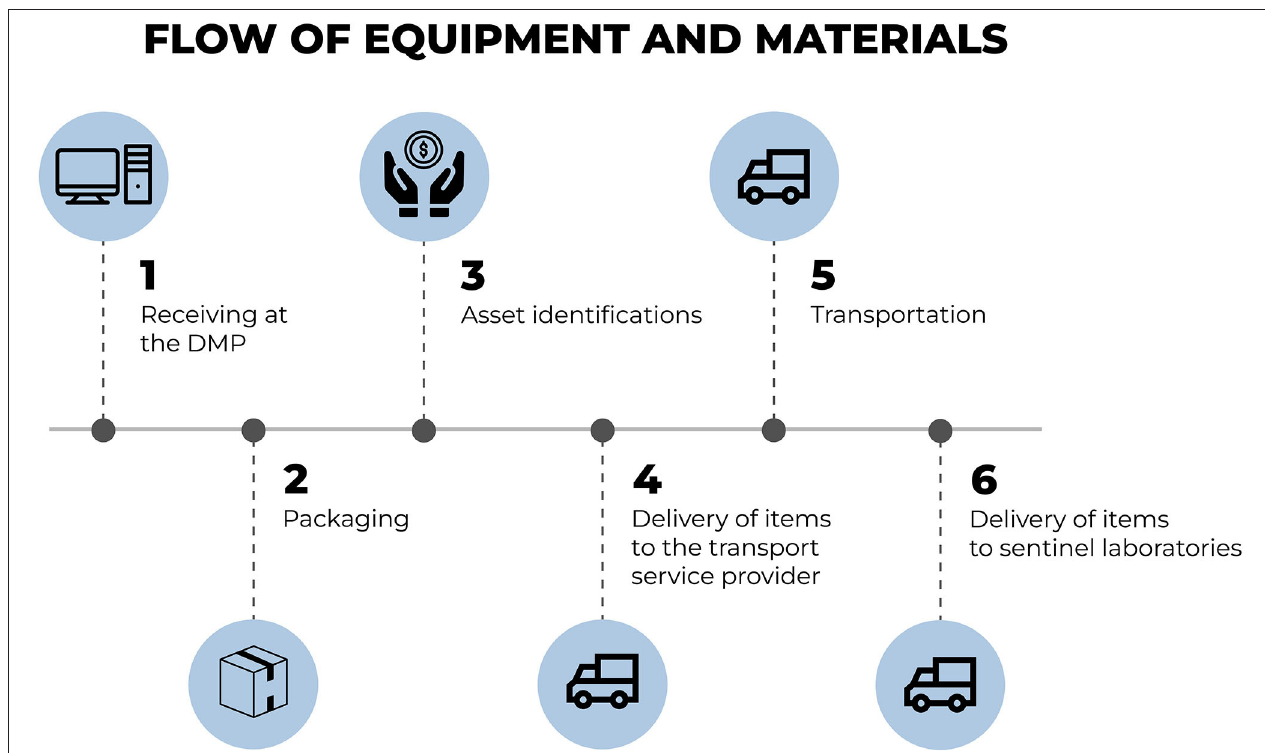
FIGURE 6 | Flow for the storage of acquired equipment and materials. Source: graphic developed by the authors.